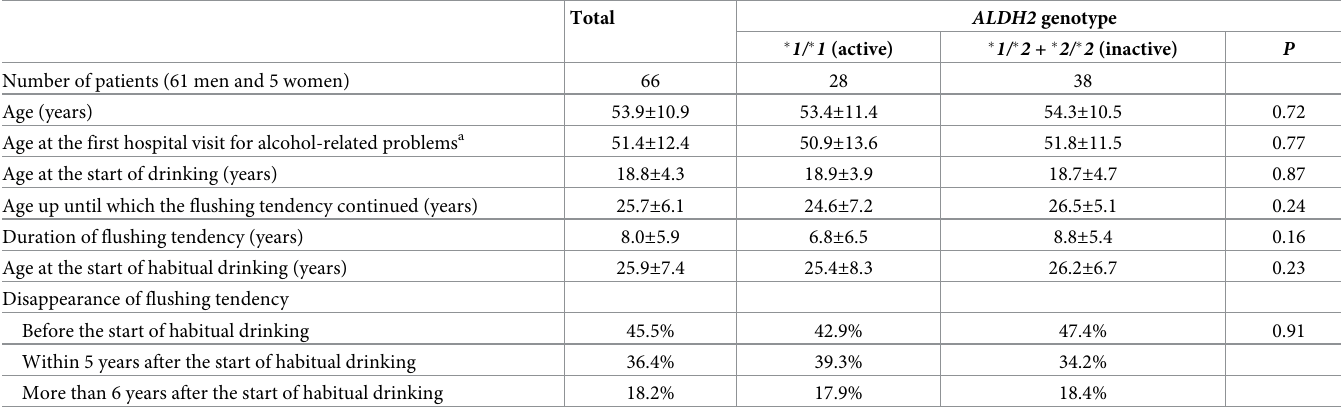
Table 6. Temporal profiles for drinking and flushing in former-flushing, alcohol-dependent subjects according to ALDH2 genotype. Total ALDH2 genotype � 1/ � 1 (active)